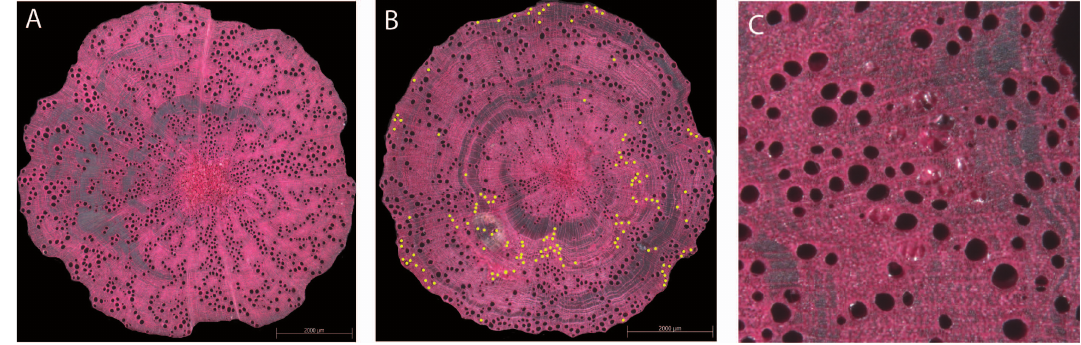
Fig. 5. Presence of tyloses in the vessels of branch xylem in the sun canopy of C. acuminatissima . (A) Control branch without tyloses, (B) drought-exposed branch with tyloses. Vessel occlusion marked with yellow spots. Many occluded vessels are located in the outermost recently produced sapwood, (C) vessels in the outermost sapwood filled with tyloses from a drought-exposed sun canopy branch.